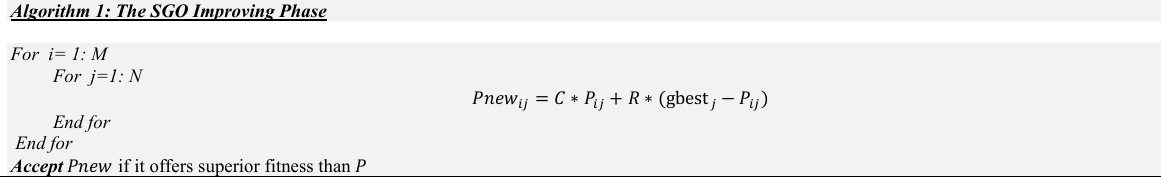
Algorithm 1: The SGO Improving Phase